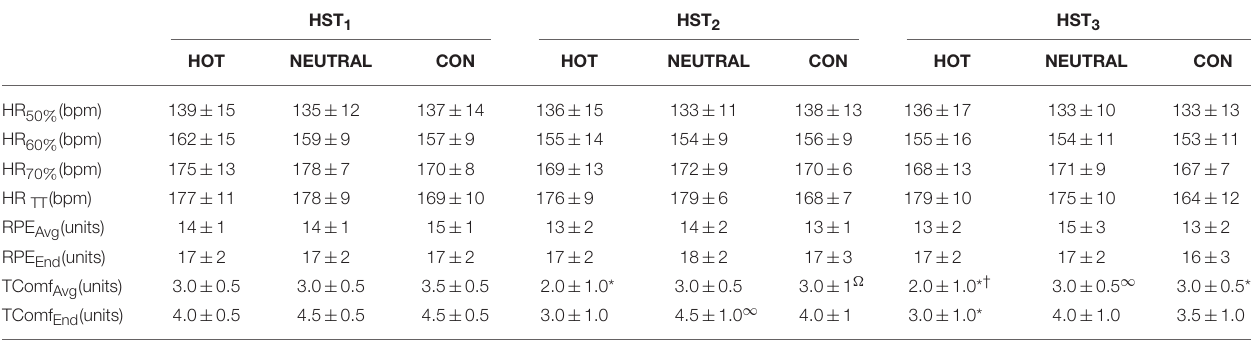
TABLE 1 | Physiological and perceptual responses to Heat Stress